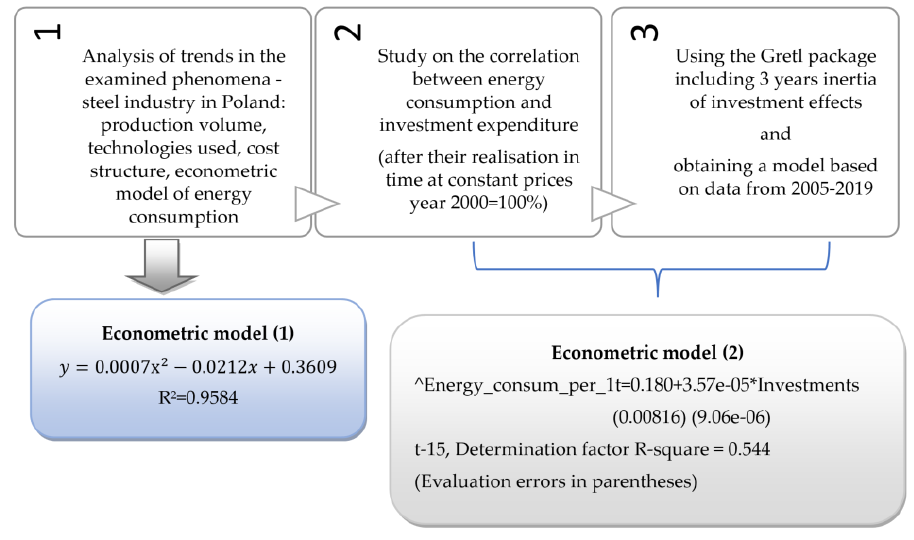
Figure 2. Research Figure 2. Research methodology.